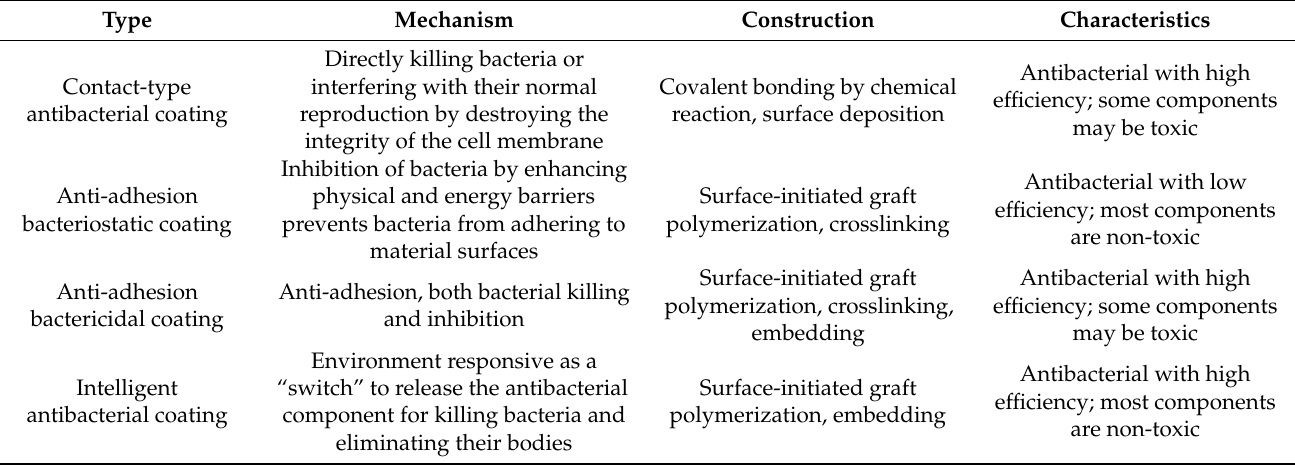
Table 2. Comparison of four kinds of antibacterial